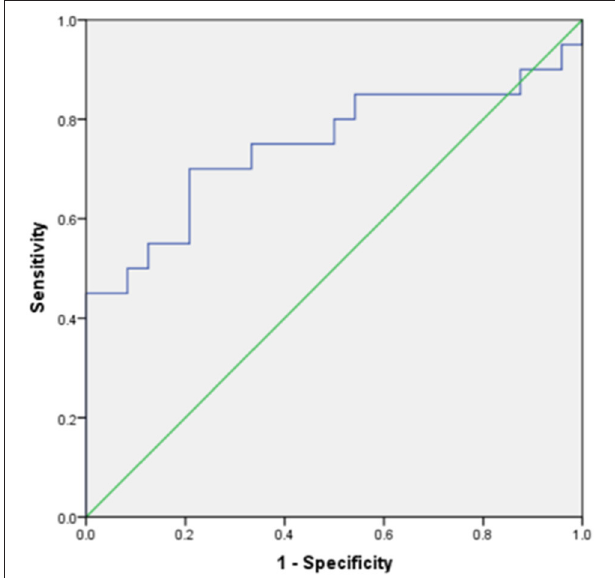
FIGURE 6 | The ROC curve of skewness in the T2WI histogram between the endometrial mesenchymal sarcoma group and degenerative hysteromyoma group.